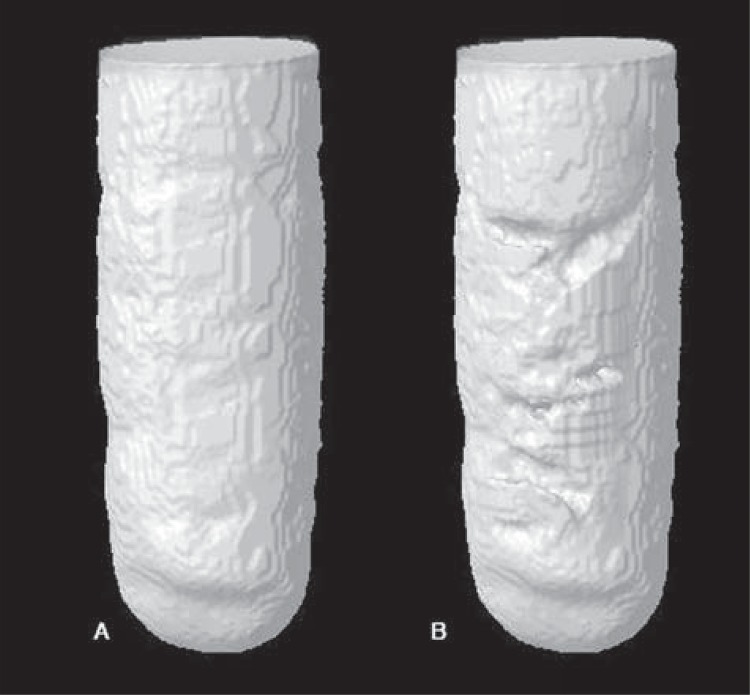
3D model from CTVol software representing the cavity filled with contrast solution (A – 100% of filling) and (B – filled with MTA)